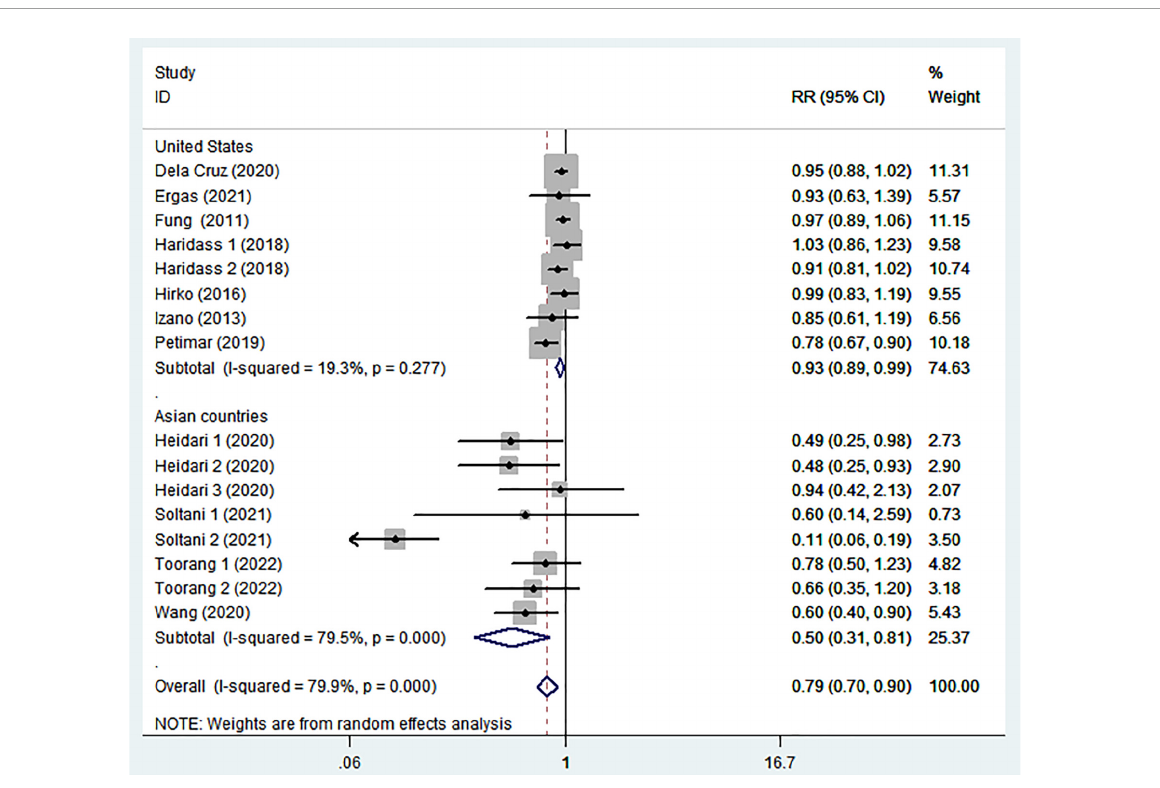
FIGURE4 Meta-analysis on the association between adherence to dietary approaches to stop hypertension (DASH) diet and breast cancer risk stratified by